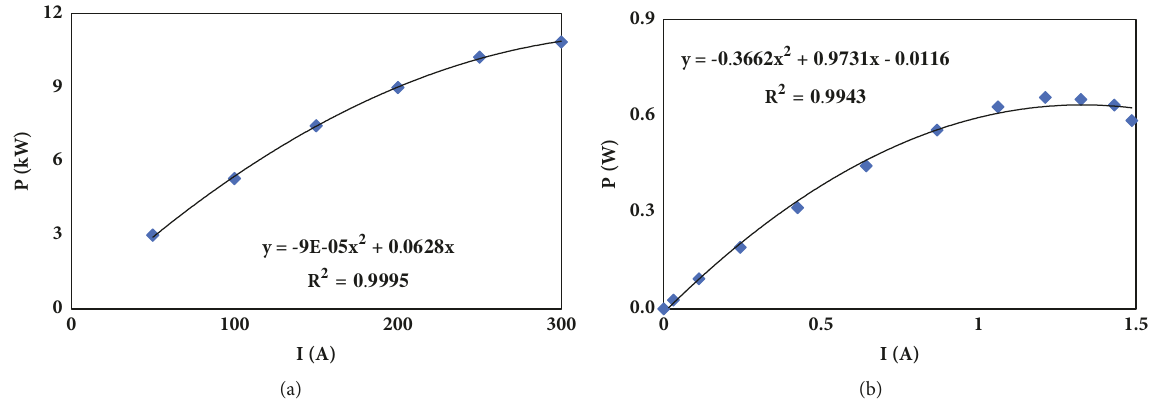
Figure 5: Graphical representation of power as a function of current intensity of two different PEM fuel cells (a) of 70 kW and (b) of 52 cm 2